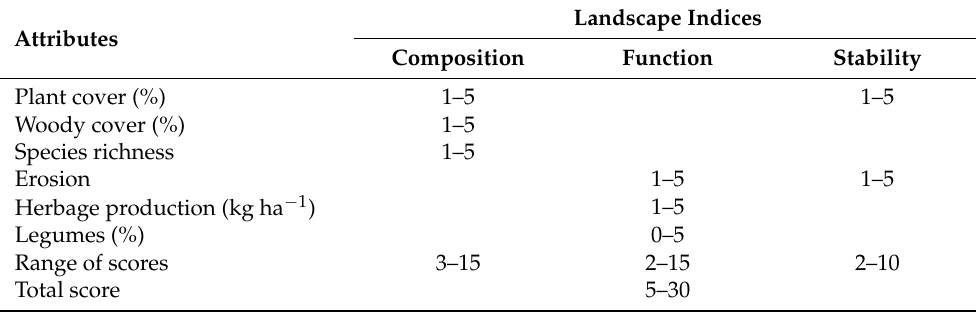
Table 1. Attributes, possible scores, and maximum scores used for calculating indices of landscape composition, function, and